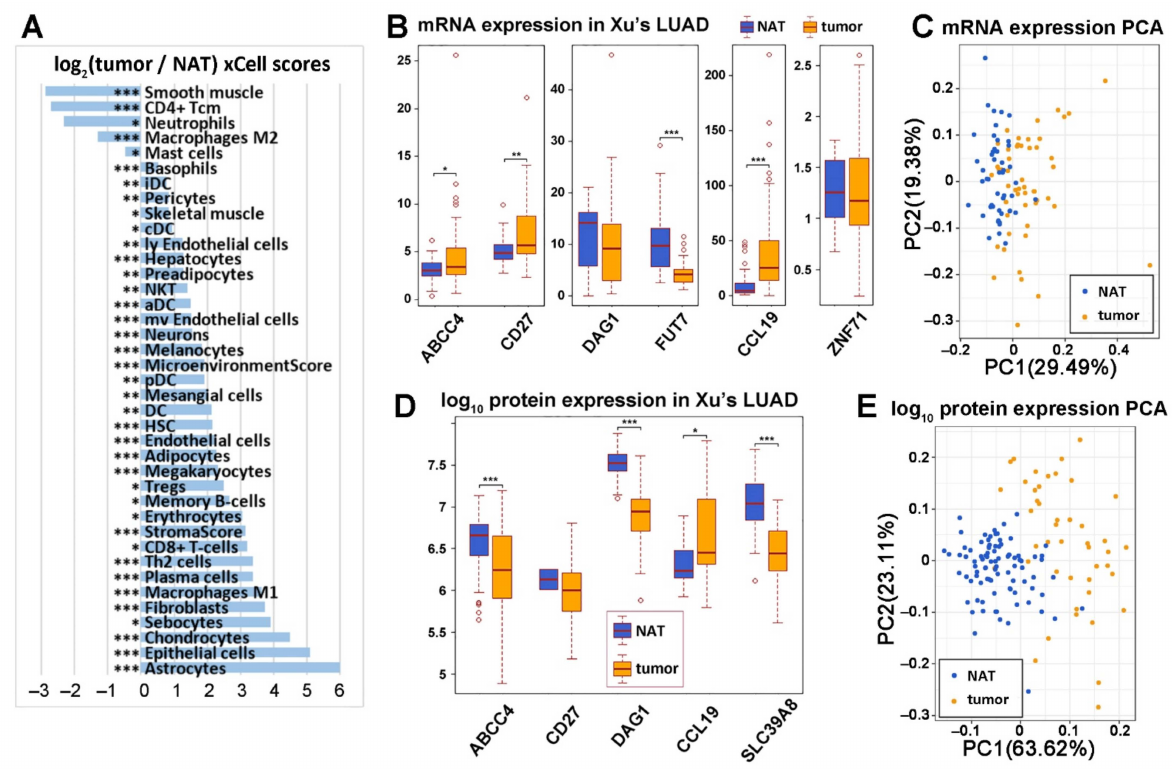
Figure 2. Classification of non-cancerous adjacent tissues (NATs) and lung adenocarcinoma (LUAD) tumors with the seven-gene panel. ( A ) Log 2 ratio of xCell scores of the LUAD tumor vs. NATs RNA sequencing data. Two sample t -tests were performed to test the difference between the two groups (*: p < 0.05; **: p < 0.01; ***: p < 0.001). Boxplots of available RNA sequencing gene expression ( B ) and protein expression ( D ) in tumors and NATs of the 7-gene panel in LUAD patients [33]. Principal component analysis (PCA) of RNA sequencing gene expression ( C ) and protein expression ( E ) in separating NATs and LUAD tumors in